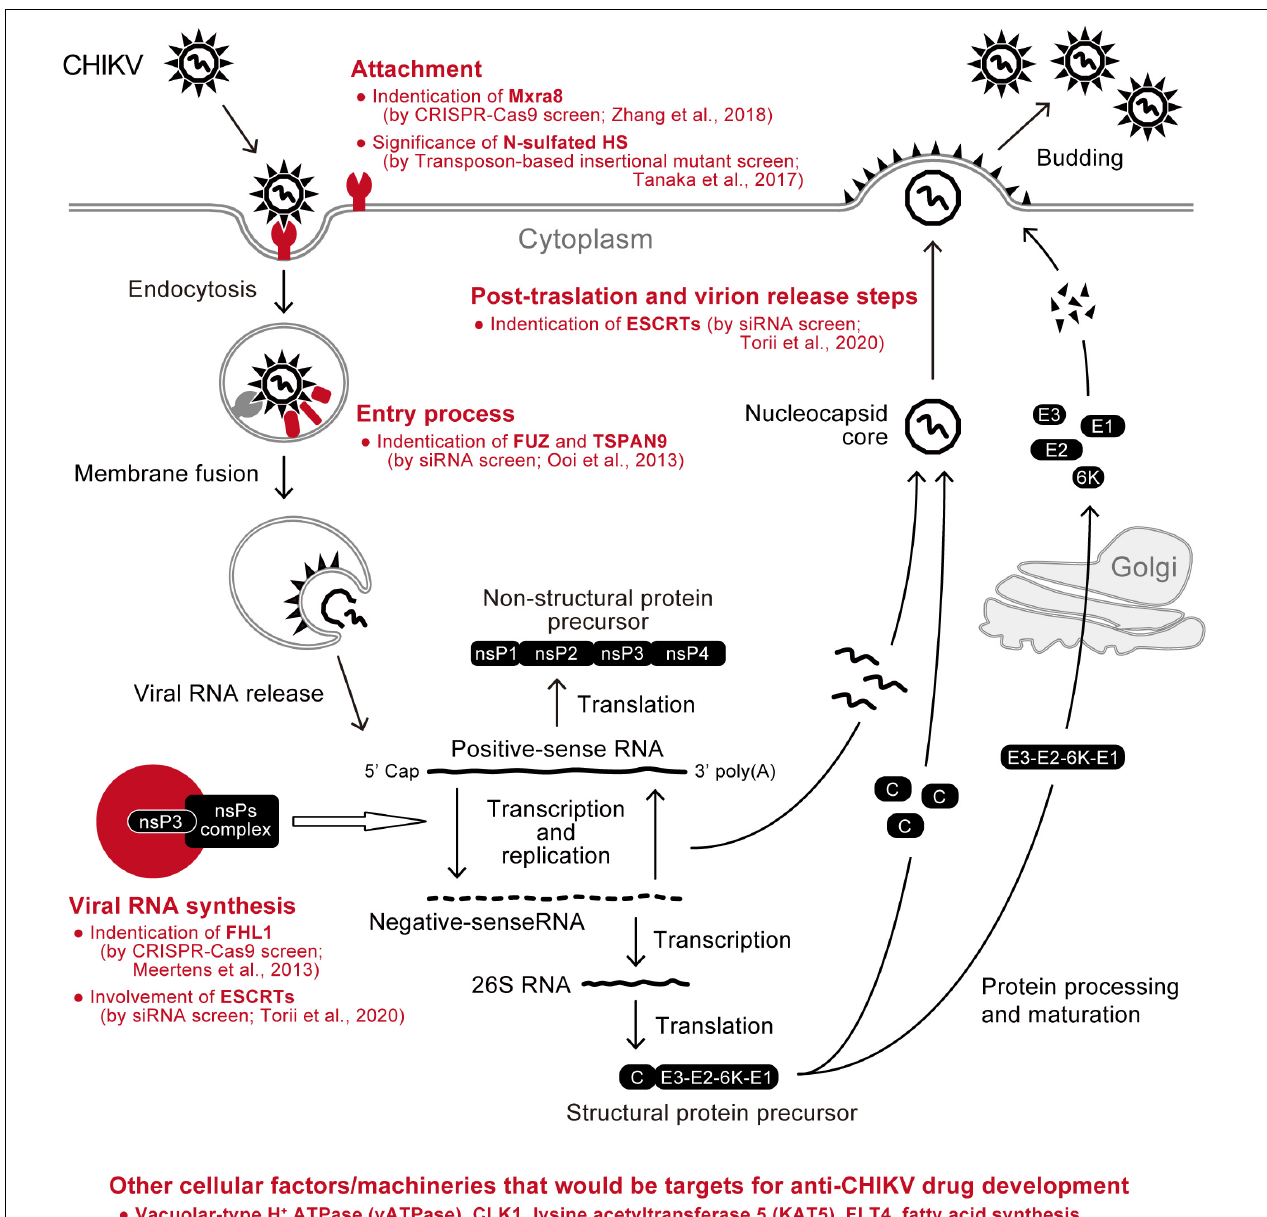
FIGURE 3 | Summary of CHIKV-related cellular factors identified by genetic screens. Cellular factors that have been found as enhancers of CHIKV replication using comprehensive screening approaches (red) are depicted in the schematic of the virus replication